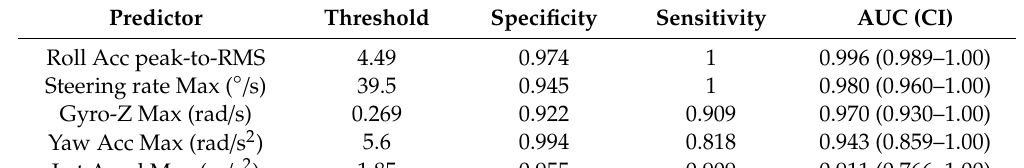
Table 3. Prediction Performance and best thresholds for the feature input.